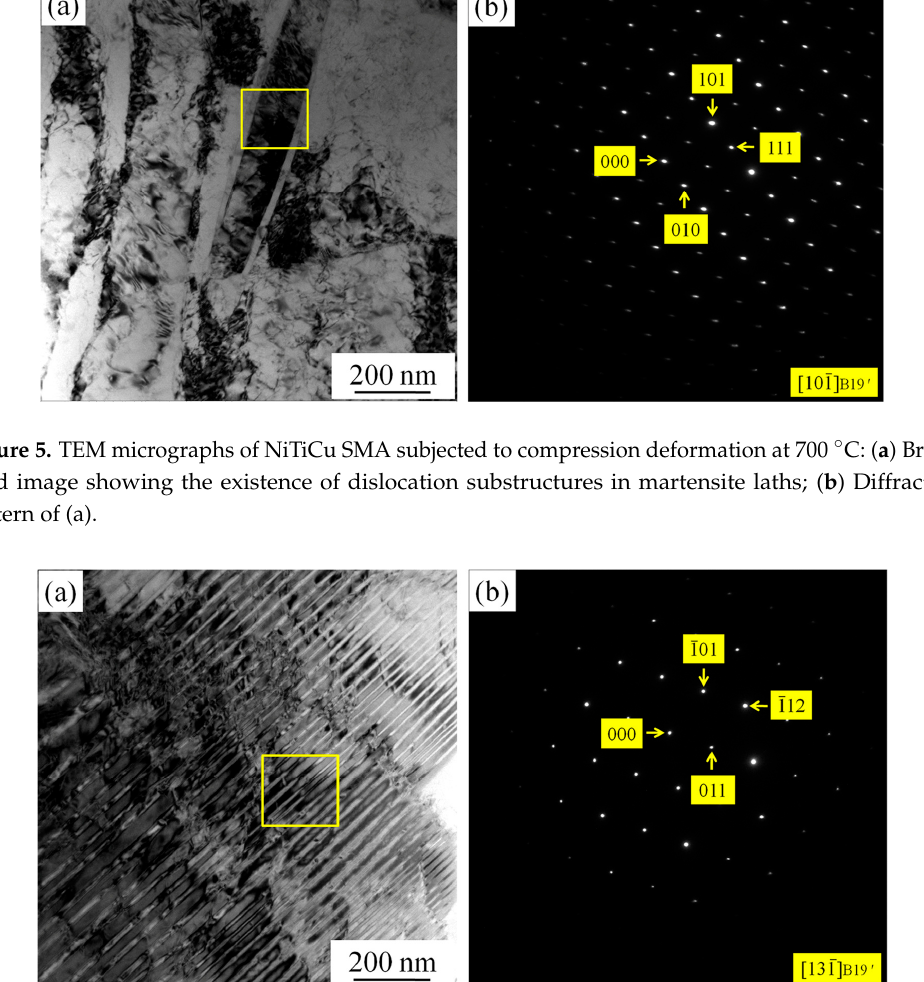
Figure 6. TEM micrographs of NiTiCu SMA subjected to compression deformation at 800 °C: ( a ) Bright field image showing the existence of martensite twins; ( b ) Diffraction pattern of (a).